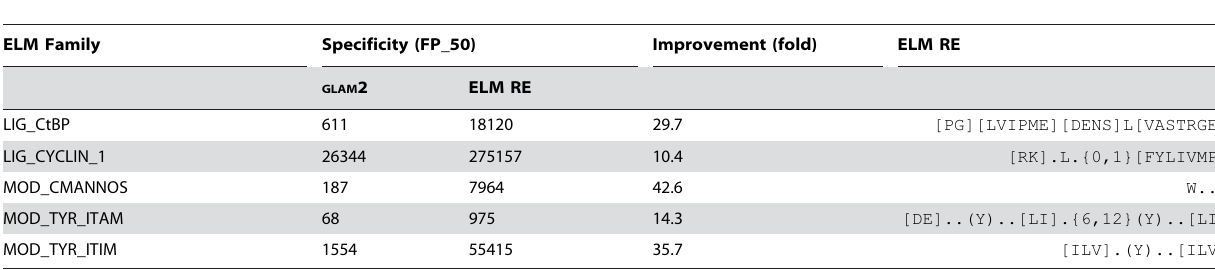
Table 2. ELM families where GLAM 2 motifs are massively more specific.